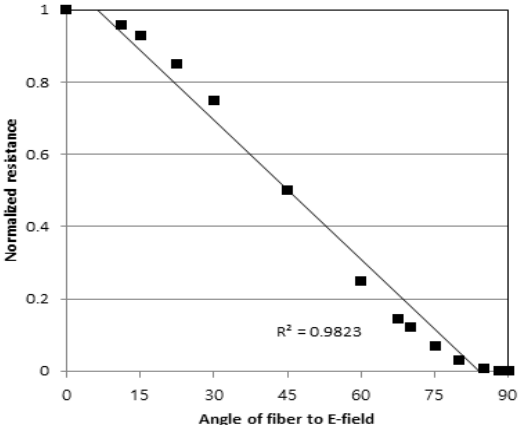
Figure 10. Relationship between the angle of the fiber and the E-field and normalized resistance in a unidirectional carbon composite laminate.